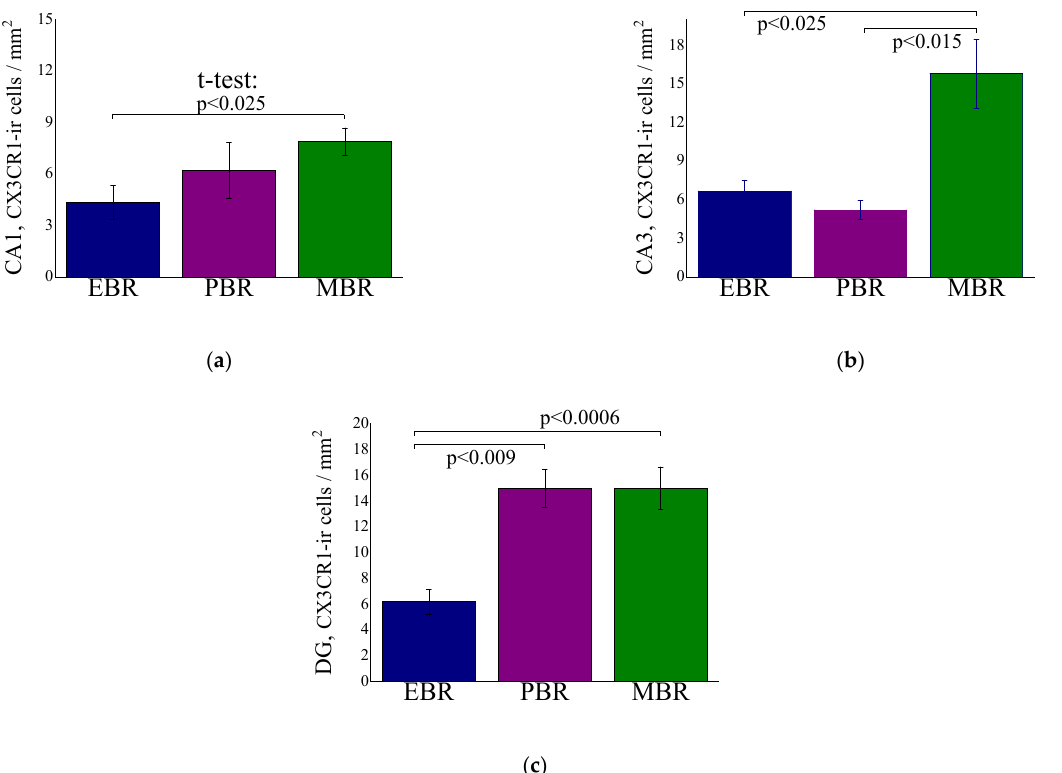
Figure 7. Quantitative analysis of CX3CR1-ir cells in the CA1 ( a ), CA3 ( b ) and DG ( c ) hippocampal subregions at day 8 post PSS-exposure in animals with an extreme behavioral response (EBR) or partial response (PBR) to the PSS exposure, and in animals whose behavior was minimally affected by the stressor (MBR). All data represent the group means ± S.E.M.